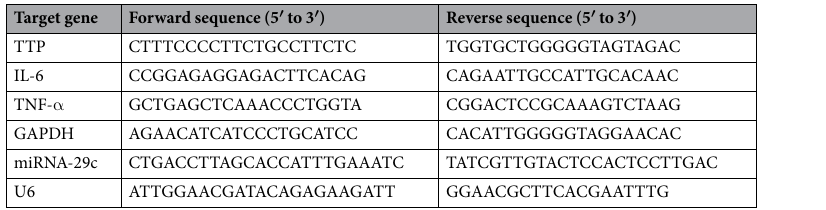
Table 3. The primers used for real-time